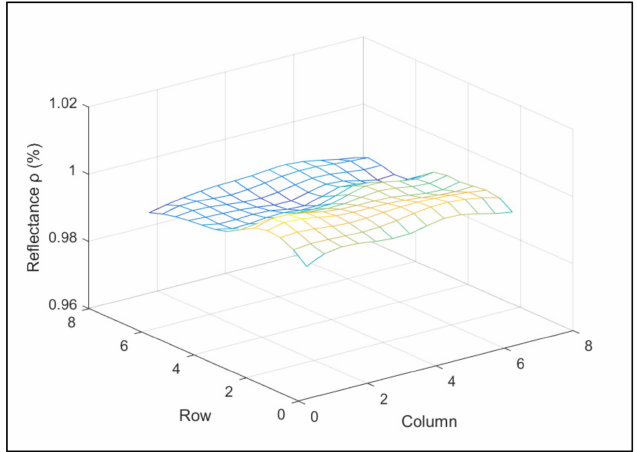
Figure 8. Nonuniformity of the integrating